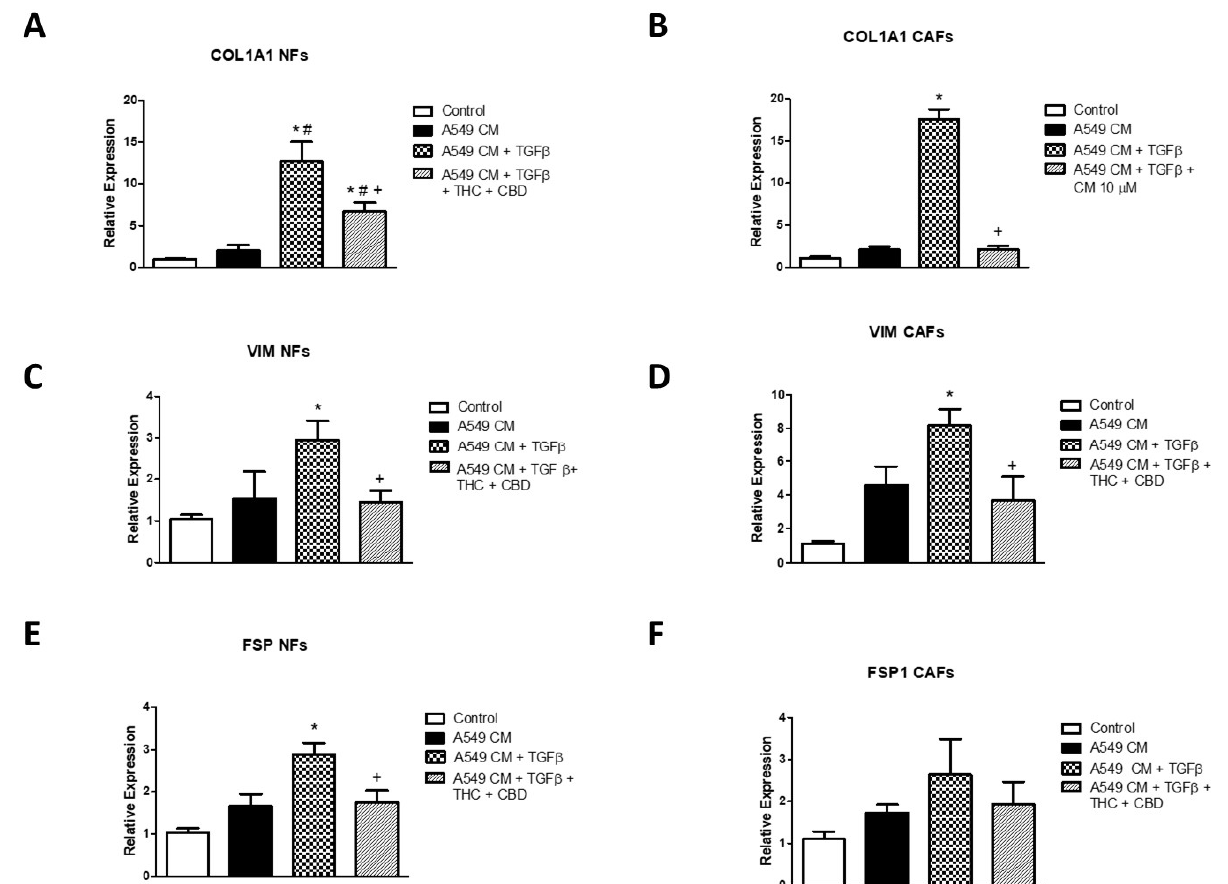
Figure 7. Effect of cannabinoid agonists on stromal cell gene expression of fibroblast-related gene changes induced by A549-cell-conditioned medium (A549CM). The culture medium was conditioned with A549 cells cultured in the presence or absence of 5 ng/mL TGF β , treated or not with an equimolar mixture of 10 µ M THC + CBD. Then, NFs ( A , C , E ) or CAFs ( B , D , F ) were cultured with this conditioned medium for 72 h. The relative gene expression of COL1A1, VIM and FSP1 was studied by real-time RT-PCR using the GAPDH as housekeeping. Average fold change ± SD of 3 different experiments is represented. A triplicate was analyzed in each of the experiments. * p < 0.05 compared to the control group (white bars). # p < 0.05 compared to the NFs or CAFs cultured with A549CM in the absence of TGF β or cannabinoid agonists (black bars). + p < 0.05 compared to the NFs or CAFs cultured with A549CM + TGF β in the absence of cannabinoid agonists (gridded